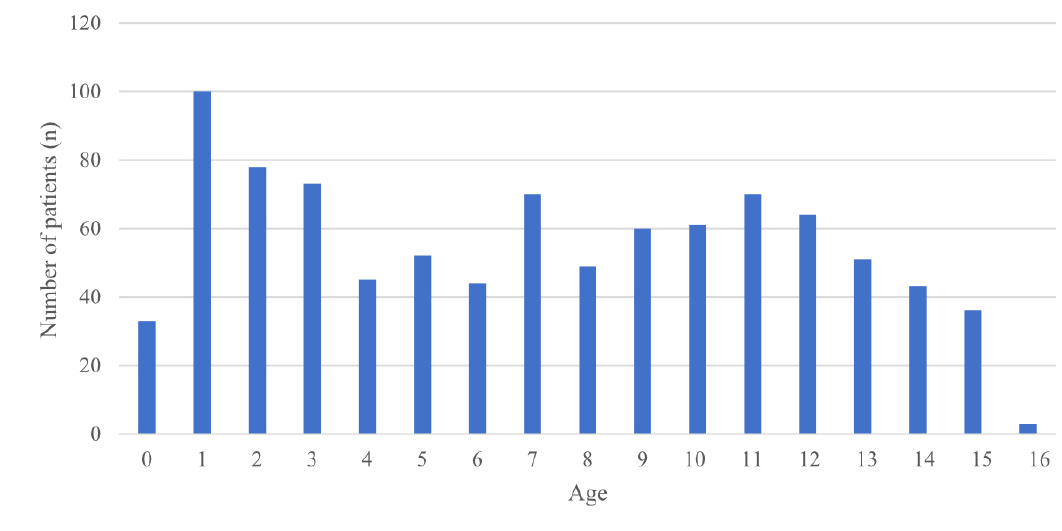
Figure 1: Age distribution of patients with hand and finger injuries.